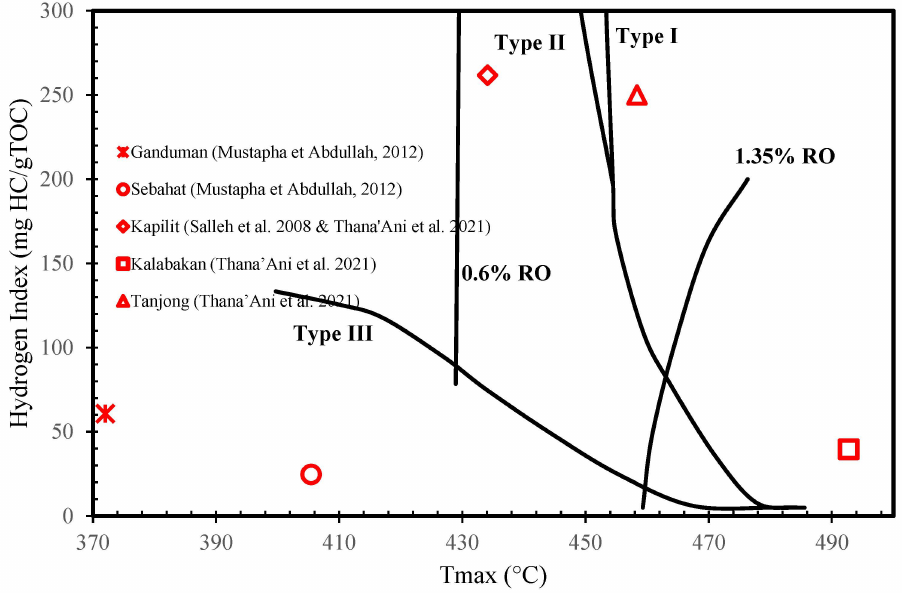
Figure 11. Tmax versus HI plot showing the type of kerogen of formations in